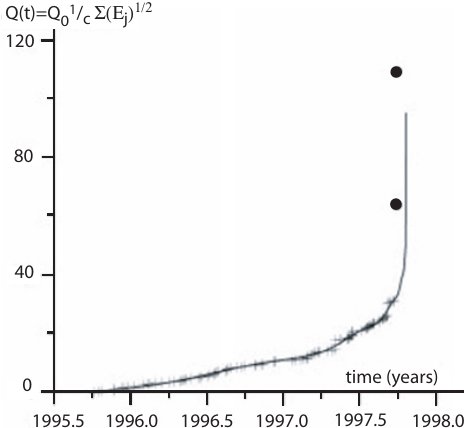
Fig. 5. Best fit solution and cumulative sum of the square root of the seismic energy released by events before the two main shocks of Sept. 26 2007 marked by black solid circles (Di Giovambattista and Tyup- kin,